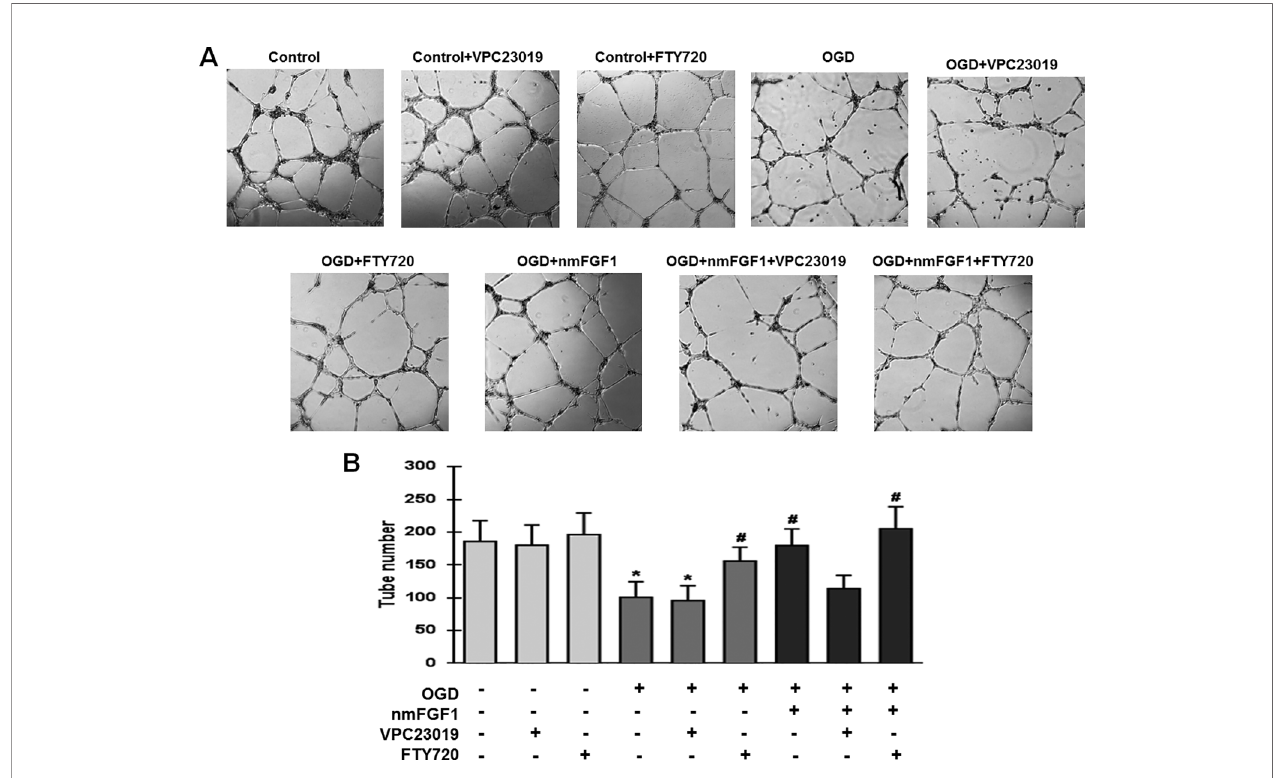
FIGURE 6 | Non-mitogenic fi broblast growth factor 1 (nmFGF1) promoted angiogenesis of oxygen-glucose deprivation (OGD)-exposed HBMECs via S1P signaling pathway. (A) Representative images showing the tube formation ability of OGD-exposed cells treated with the S1PR1 inhibitor VPC23019 (40 nM) and agonist FTY720 (50 nM) in the presence or absence of nmFGF1. (B) Quanti fi cation of the effects of the S1P1 inhibitor VPC23019 (40 nM) and agonist FTY720 (50 nM) in the presence or absence of nmFGF1 on tube formation ability. Date are means ± SEM (n = 6). *p < 0.05 as compared to the control group, # p < 0.05 as compared to the OGD-treated